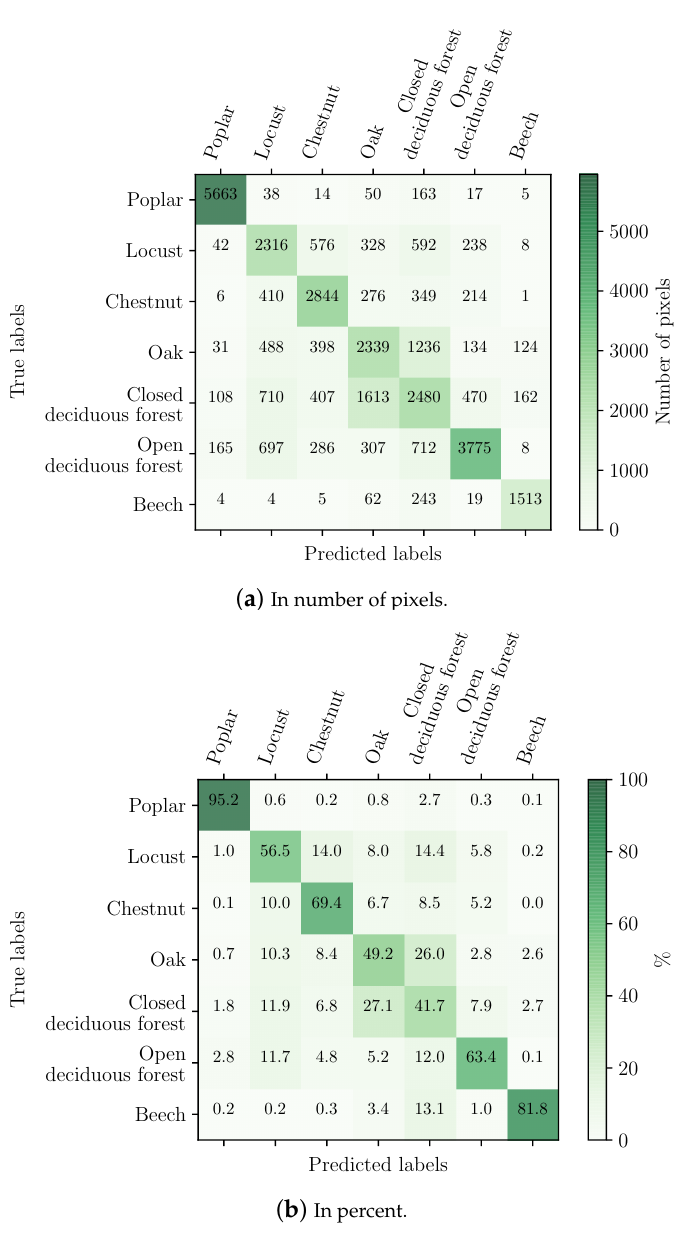
Figure A2. Confusion matrix in ( a ) pixels and ( b ) percent. The PA of poplar class is 95%. The UA is 94%, and the F-score is